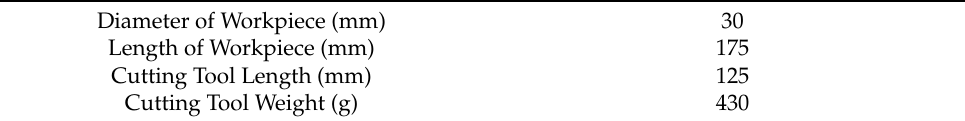
Figure 2. Feeler turning machine (Model: FTC-10) used in experiments. Table 3. Specifications of workpiece and cutting tool. Table 3. Specifications of workpiece and cutting tool.